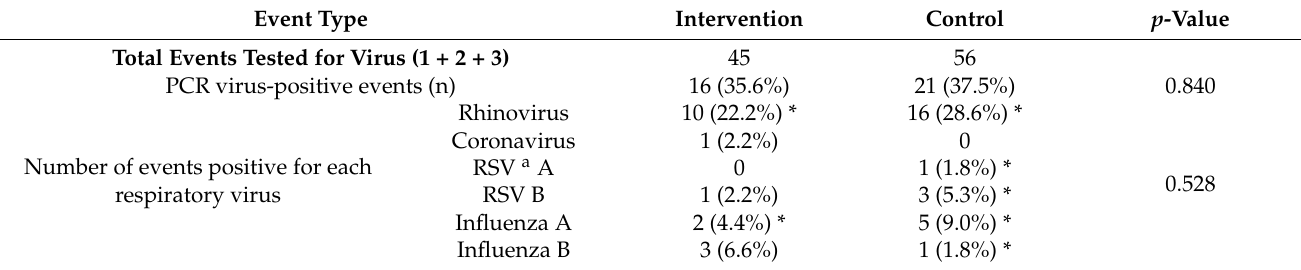
Table 5. qPCR for common respiratory viruses in asthma exacerbations and upper respiratory tract infections in children with asthma during 6-month dietary intervention